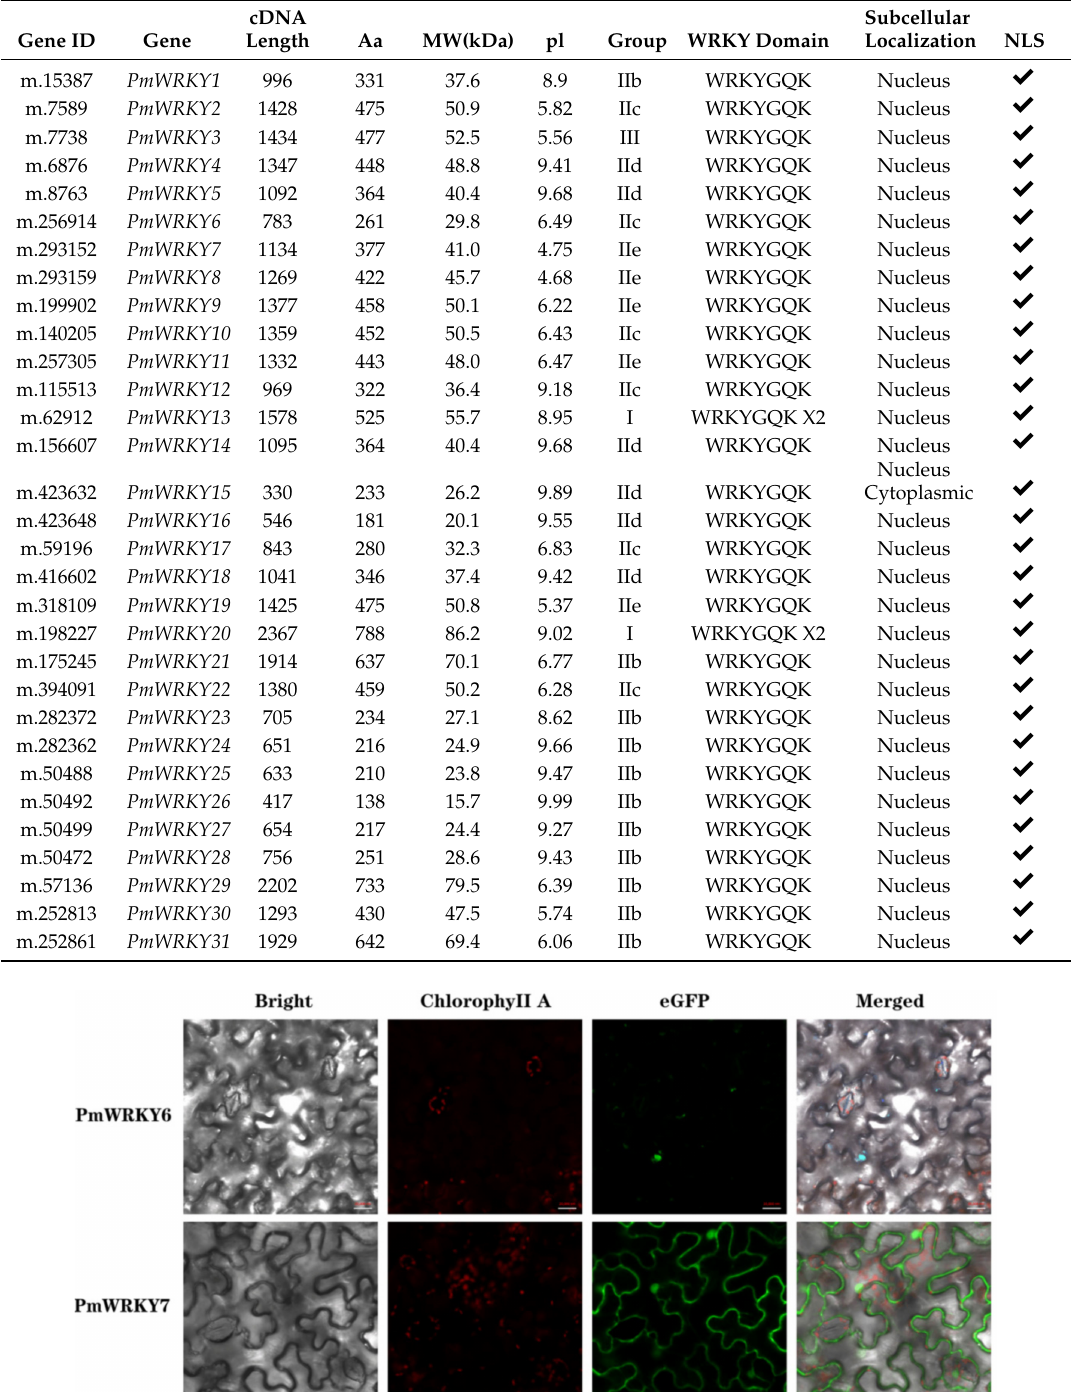
Figure 1. Subcellular localization of PmWRKY6 and PmWRKY7 in Nicotiana benthamiana. 3.2. Phylogenetic Analysis of PmWRKY Proteins Based on the classification in Arabidopsis , 65 AtWRKY proteins from various groups or subgroups were randomly selected as representatives for comparison with P. massoniana and P. taeda based on previous studies [14,23]. The most prominent feature of WRKY proteins is the 60-amino-acid WRKY domain, which comprises the highly conserved signature "WRKYGQK" followed by a C2H2- or C2HC-type zinc finger motif [4]. As a result, the alignment of the PmWRKY proteins was examined based on their WRKY domains, which span ~60 amino acids. According to the combined alignment results, PmWRKY basically contains the conserved heptapeptide "WRKYGQK" in its domain sequence (Figure 2). The phylogenetic relationship among the WRKY domains of the PmWRKY , PtWRKY and AtWRKY proteins was studied as shown in Figure 3. The phylogenetic analysis indicated that PmWRKY proteins can be divided into three major groups, corresponding to groups I, II and III, when compared with the proteins from A. thaliana [3]. Of the 31 PmWRKY proteins, 2 belong to group I, 28 to group II, and 1 to group III. In group II, WRKY proteins can further be classified into five subgroups: 0 PmWRKY proteins belong to IIa, 11 to IIb, 6 to IIc, 6 to IId and 5 to IIe （ Table 2 ） .